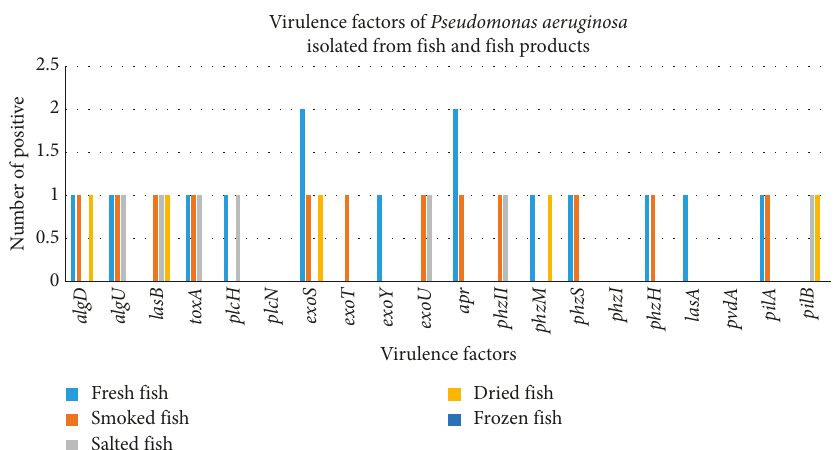
Figure 4: Virulence factors of Pseudomonas aeruginosa isolated from fish and fish